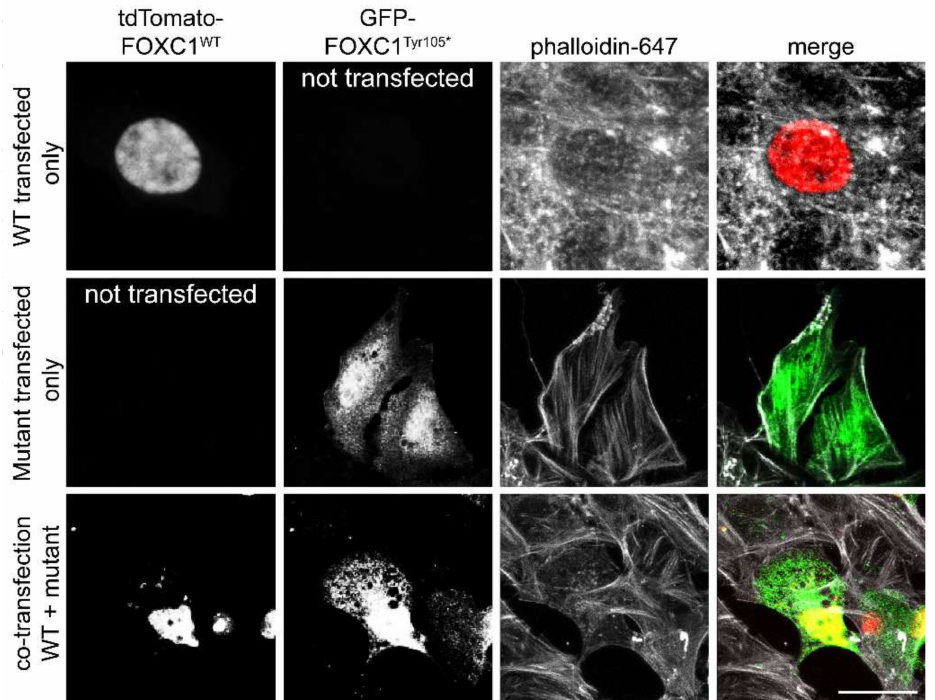
Figure 2. Representative images of COS-7 cells transiently transfected with tomato-tagged wild-type (WT) or FOXC1 constructs. As compared to WT-FOXC1, which is primarily localized in the nucleus, the truncated FOXC1 was also found in the cytoplasm. Scale bar—10 µ